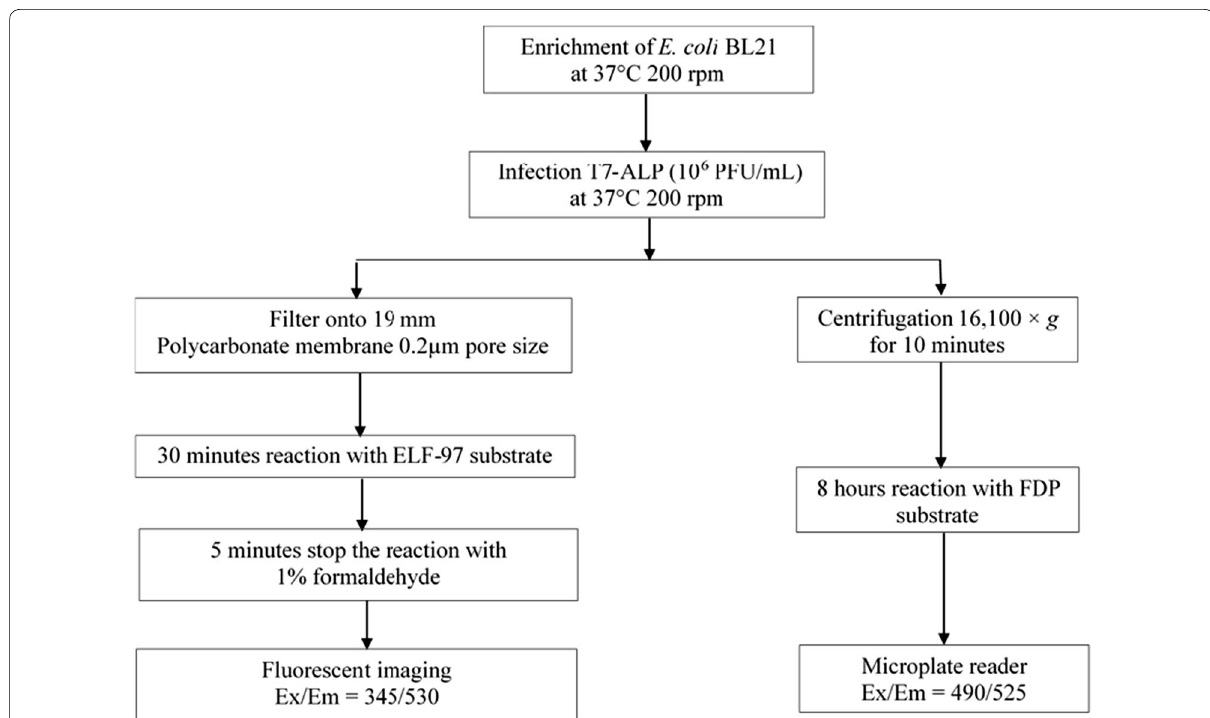
Fig. 1 Schematic diagram of detection protocol based on alkaline phosphatase activity assay using soluble alkaline phosphatase substrate (FDP) and insoluble alkaline phosphatase substrate